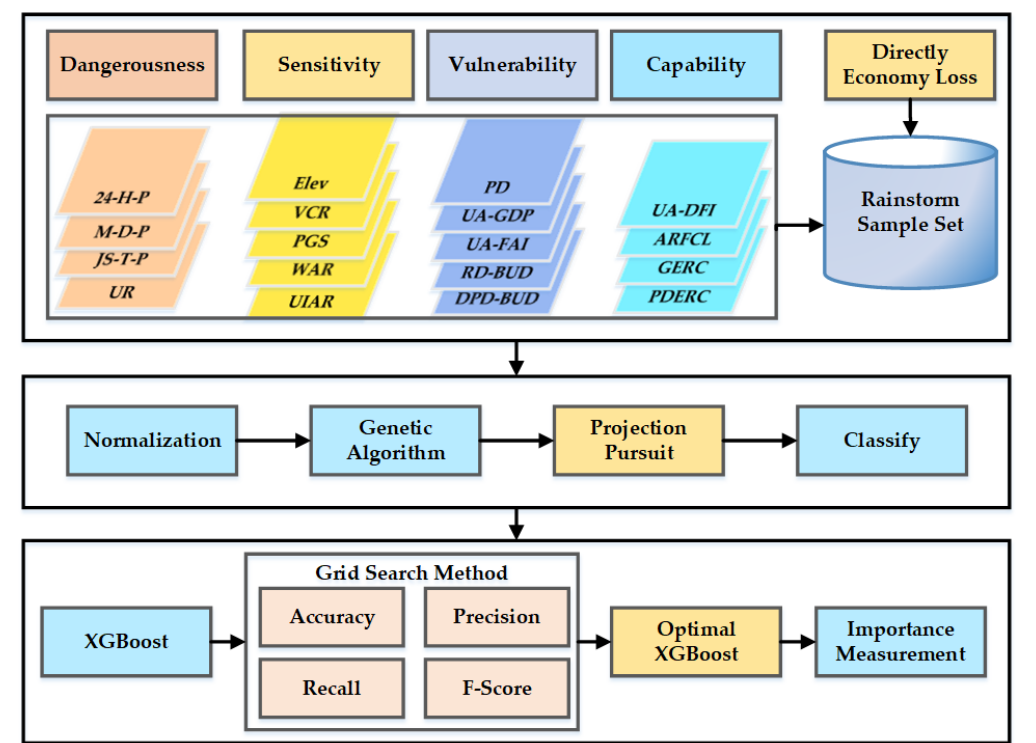
Figure 3. Rainstorm disaster risk assessment and influencing factors analysis based on GAPP-XGBoost.